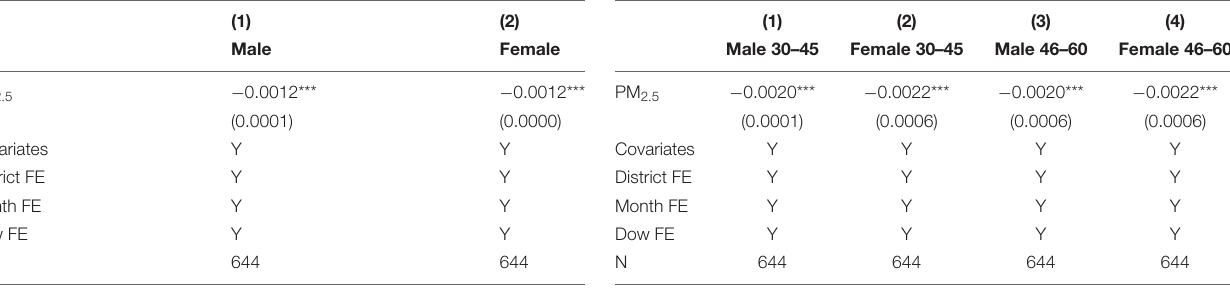
TABLE 8 | Interactions with gender and age.